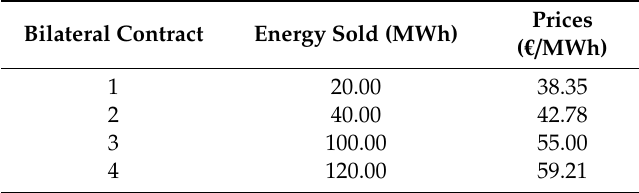
Table 2. Electricity bilateral contracts—energy and prices.